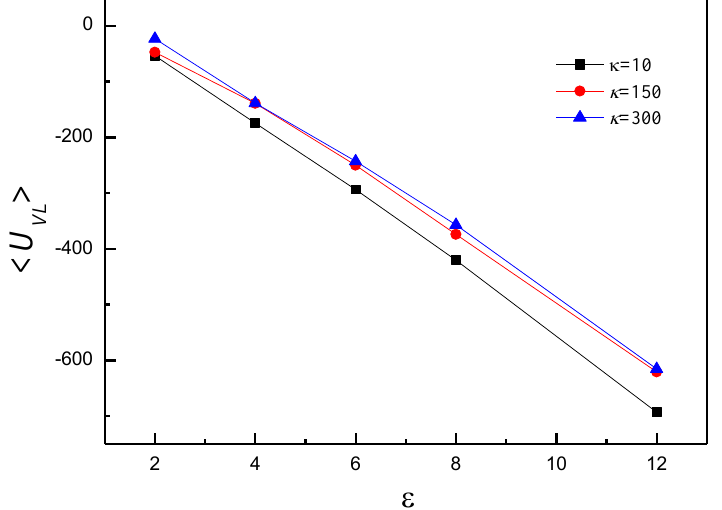
Figure 6. The average attractive energy < U VL > between the semiflexible polymer chain and vesicle versus ε VP for κ = 10, 150, and 300.